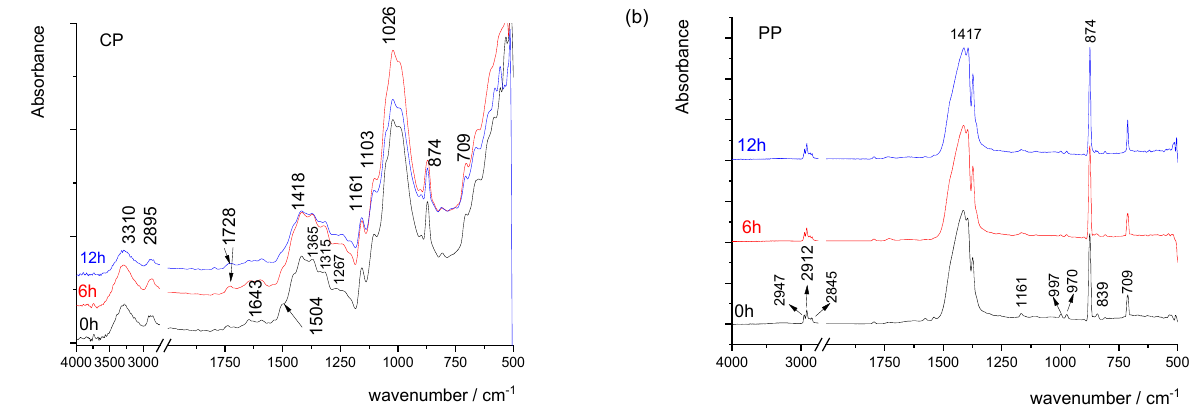
Figure 1. FTIR spectra of the cellulose-based ( a ) and polypropylene-based ( b ) paper before and after exposure to UV radiation.